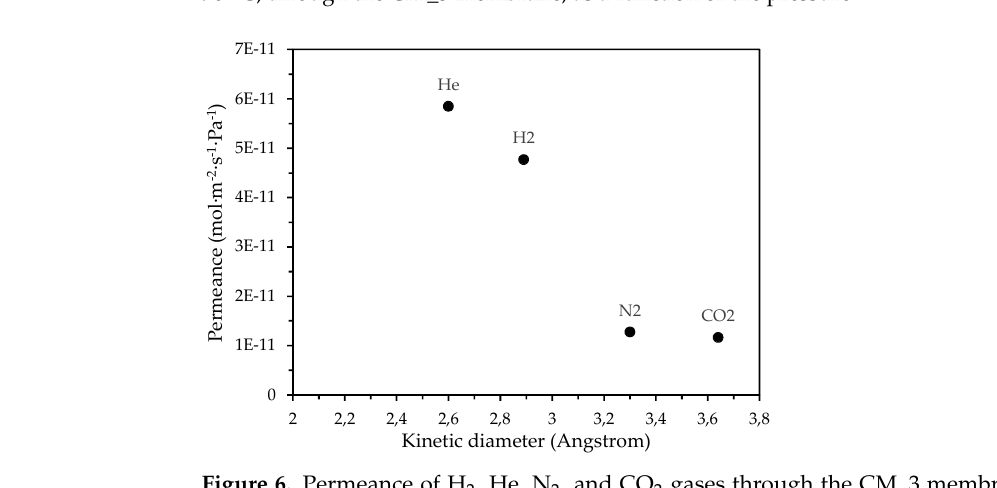
Figure 5. Permeance of ( a ) Η 2 and Ν 2 gases at 25 and 90 °C and ( b ) Η 2 , Ηe, Ν 2 , and CO 2 gases at 90 °C, through the CΜ_3 membrane, as a function of the pressure.